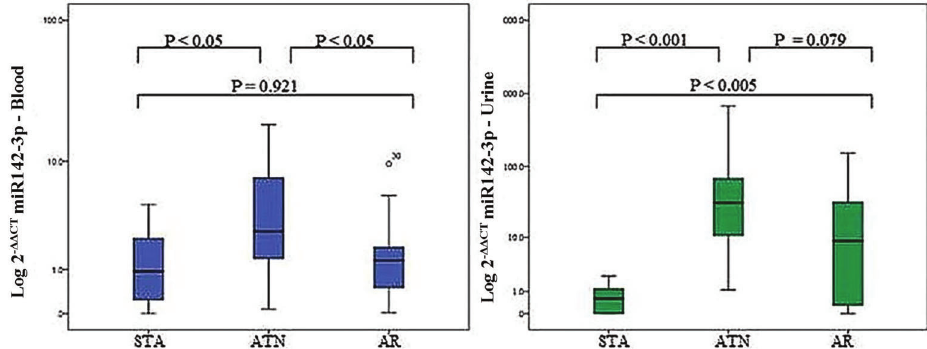
Figure 1. Logarithmic transformation of microRNA 142-3p expression in the peripheral blood and urine of renal transplanted recipients. STA: stable group of patients; ATN: group of patients with acute tubular necrosis; AR: group of patients with acute rejection. Data are reported as medians and interquartile range. Statistical analysis was performed with Mann-Whitney U test.